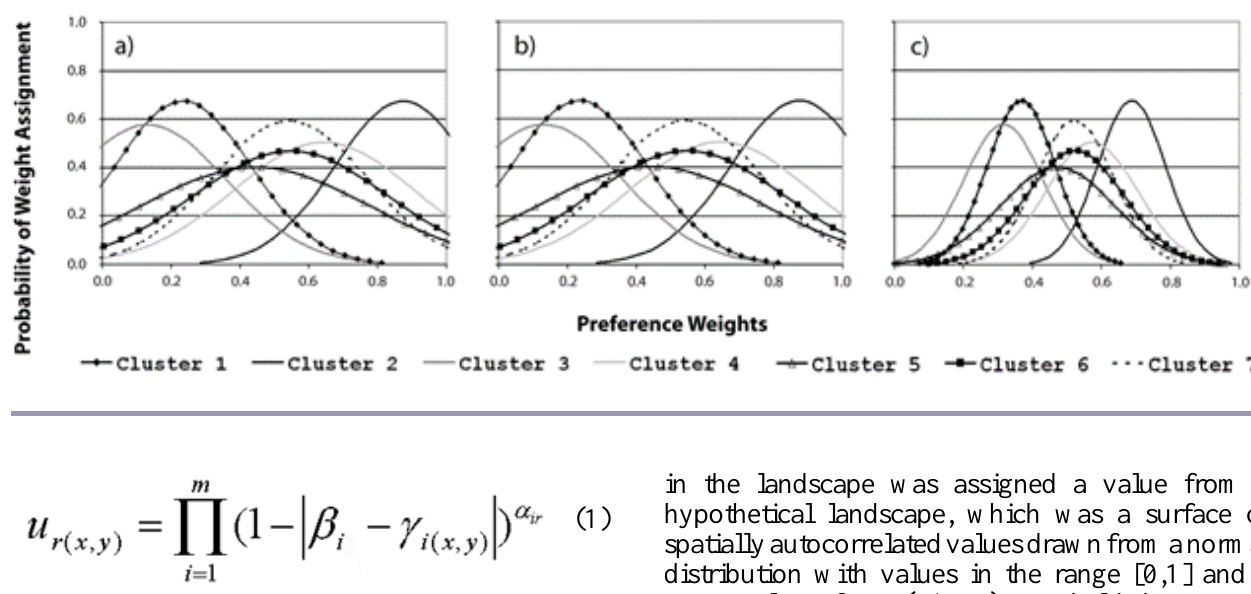
Fig. 2. Standard deviation scaling for the social comfort factor. Distributions for each of the seven groups were derived using the mean and standard deviation factor scores for each group. Distributions were cut off at ± a) 1.5, b) 2, and c) 3 standard